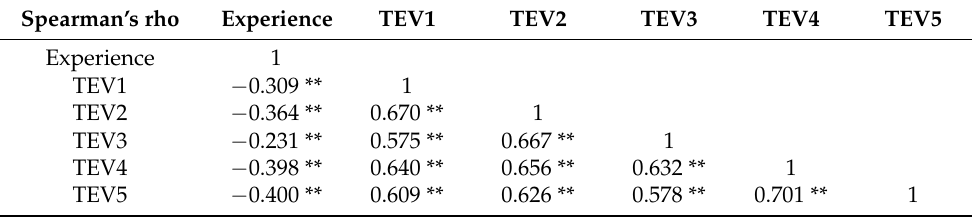
Table 10. Correlation coefficient between the H&S considerations at the tender evaluation. Spearman’s rho Experience TEV1 TEV2 TEV3 TEV4 TEV5 Experience 1 TEV1 − 0.309 ** 1 TEV2 − 0.364 ** 0.670 ** TEV3 − 0.231 ** 0.575 ** 0.667 ** TEV4 − 0.398